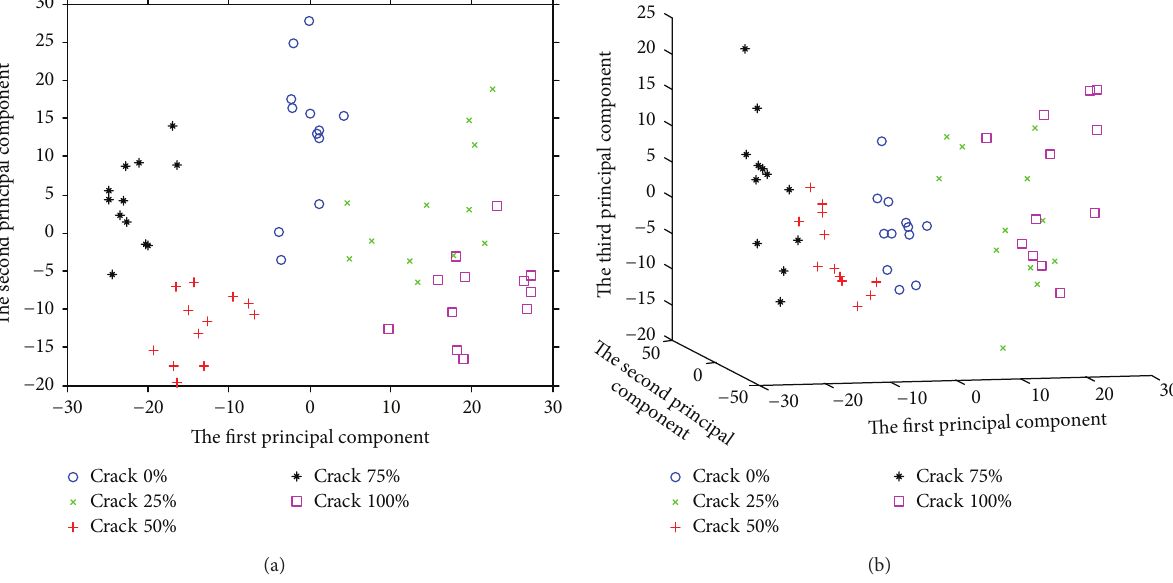
Figure 7: The principal components of the testing data for experiment 1 : (a) the first two principal components; (b) the first three principal